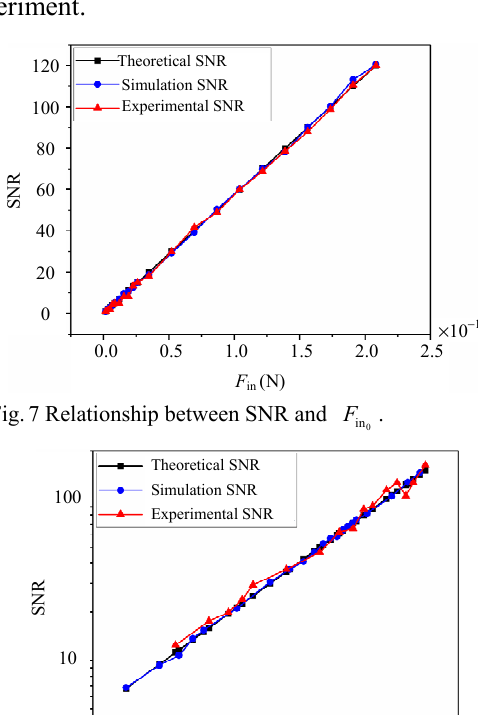
Fig. 8 Relationship between SNR and